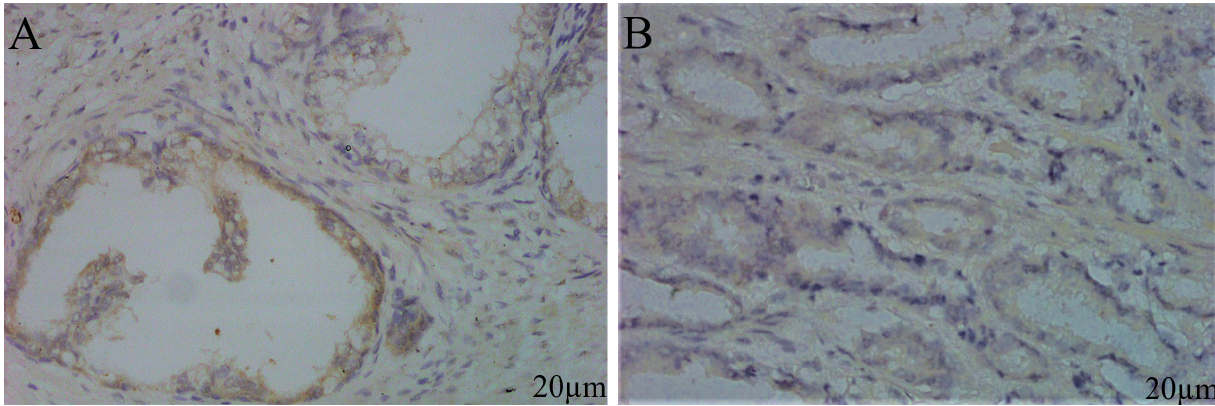
Fig. 2. Immunohistochemically stained with WWOX. (A) Adenomatous hyperplasia. Moderate cytoplasmic staining is observed (WWOX, × 400). (B) Prostate adenocarcinoma. Mild cytoplasmic staining is seen (WWOX, × 400).